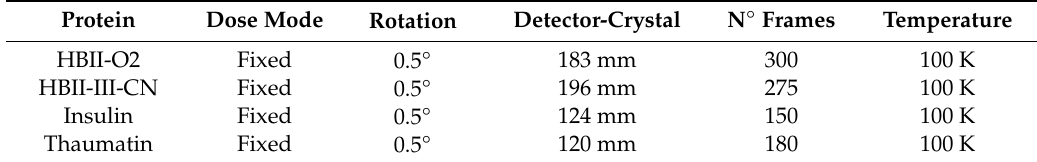
Table 2. X-ray data collection